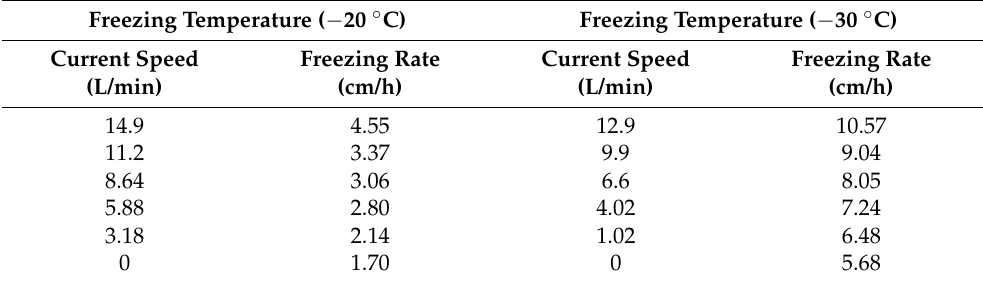
Table 6. Flow rate and freezing rate of refrigerant carrier. Reprinted with permission from Ref. [21]. 2012, Deng, M.; Zhu, Z. More details on “Copyright and Licensing” are available via the following link: cnki.net.